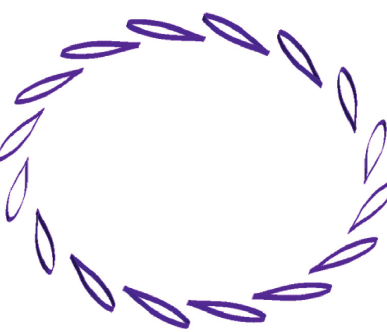
Figure 6: Power turbine.